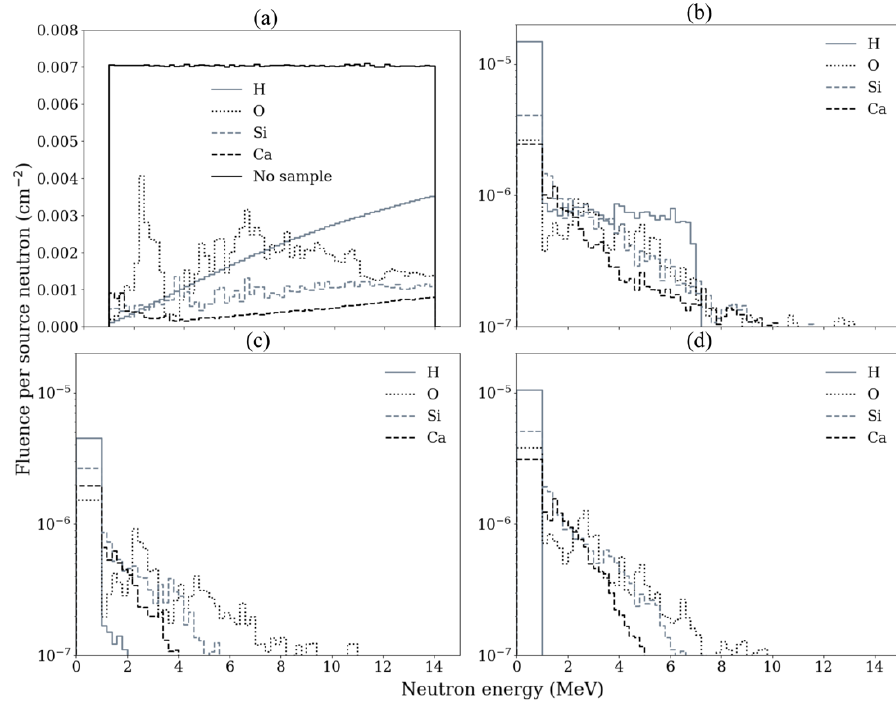
Fig. 2. Energy dependent neutron fluence, per source neutron, for elemental samples in the detector regions at (a) 0 ° , (b) 45 ° , (c) 90 ° and (d) 135 ° relative to the beam axis. Note that a log fluence scale is used for the scattered spectra